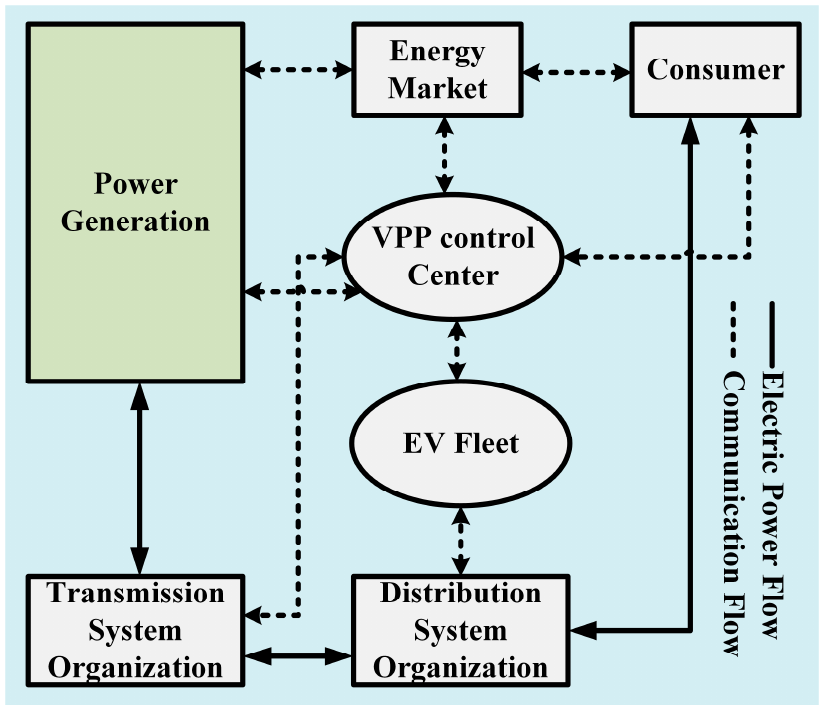
Figure 62. VPP architecture and control [117]. Table 26. Unidirectional and bidirectional V2G characteristics. Adapted from [1].